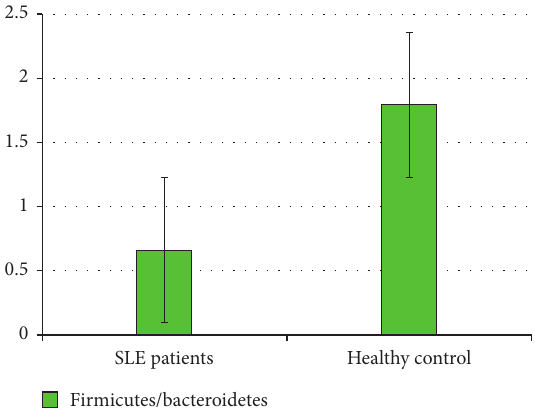
Figure 1: Difference in F/B ratio between SLE patients and healthy controls.